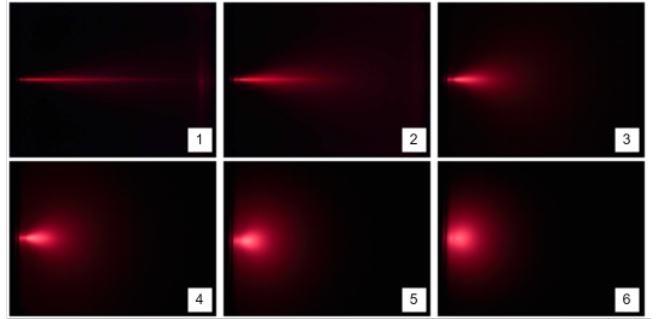
Figure 8. Effects of multiple scattering in colloids [56]. The first picture shows us an aquarium filled with water and a collimated laser beam running the full length of it. When milk is sequentially added to water (2–6), the solution becomes colloidal and there is spatial and angular spreading of the laser beam (Tyndall effect). At the point of picture 6, the laser spreading is essentially diffuse and has no longer the directionality present in the first